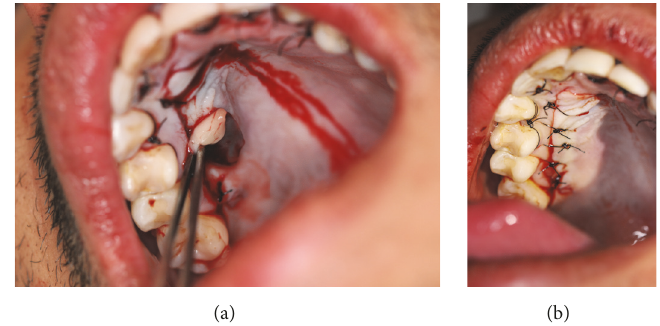
Figure 8: (a) Insertion of platelet-rich fibrin on the palate. (b) Simple suture on the donor site.